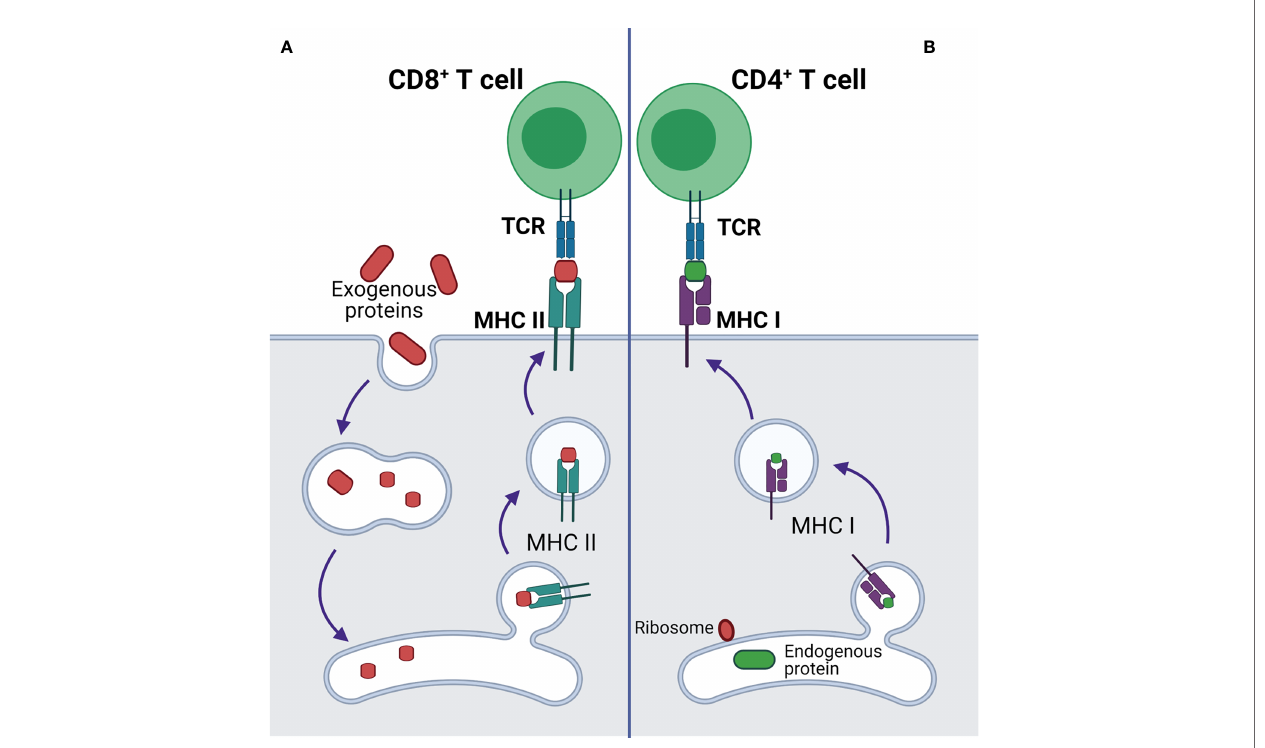
FIGURE 1 | Antigen presentation by MHCI and MHCII complexes. (A) Presentation of exogenous antigen to CD4+ T cell by MHCII after lysosomal protein processing. (B) Presentation of endogenous antigen (endogenous mutant protein or exogenous protein, e.g. viral protein) to CD8+ T cell by